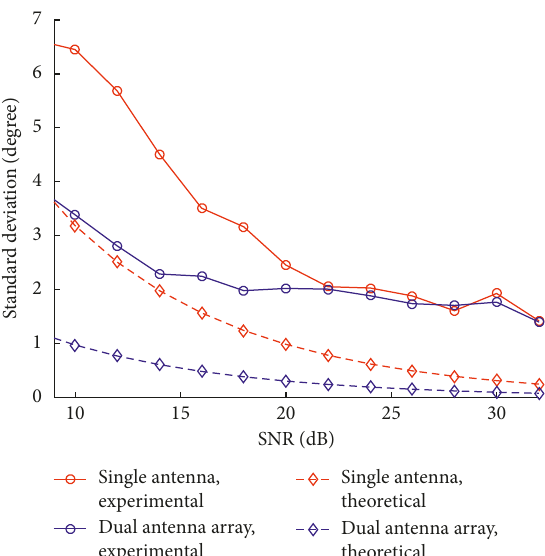
Figure 7: Comparison of simulated and experimental DOA estimation errors at different SNRs. The incident azimuth of the signal is − 20 °